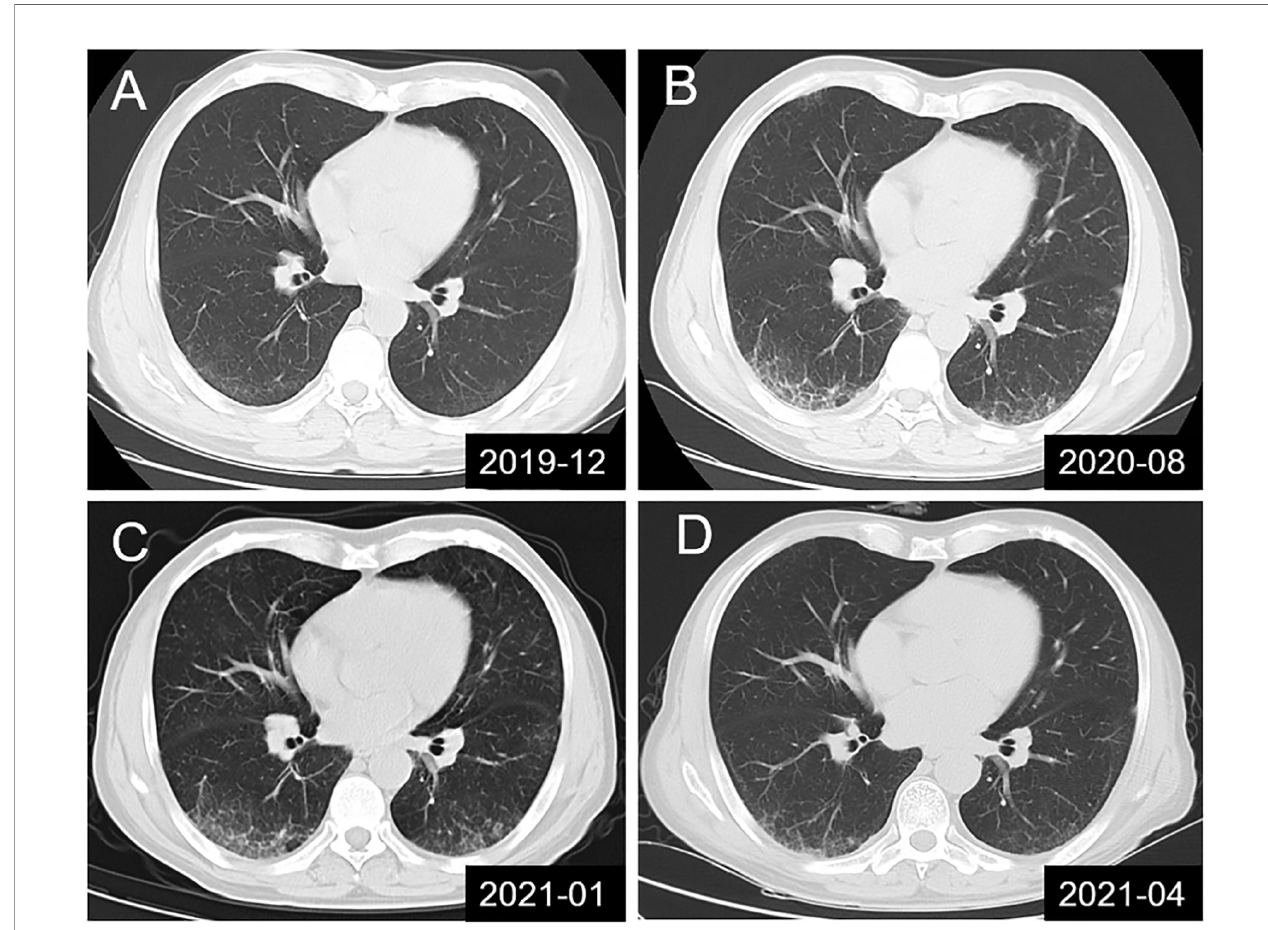
FIGURE 1 | Lung CT scans showing dynamic changes in interstitial pneumonia in the studied patient. (A) Mild interstitial pneumonia found during physical examination; (B, C) Dynamic monitoring before treatment and in the absence of clinical symptoms; (D) Signi fi cant improvement in interstitial pneumonia was observed in the results of lung CT re-examination at 10 days after combination therapy with intravenous immunoglobulin, methylprednisolone and